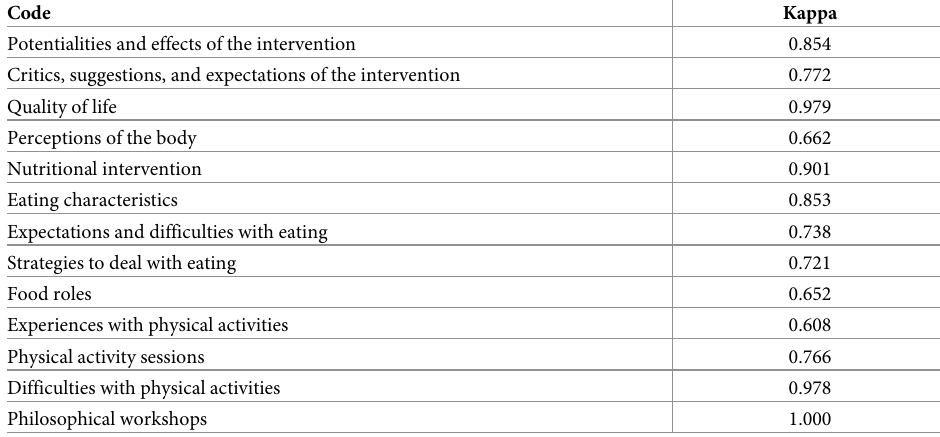
Table 3. Codes and kappa coefficients from focus groups with participants in the “Health and Wellness in Obe- sity” study.